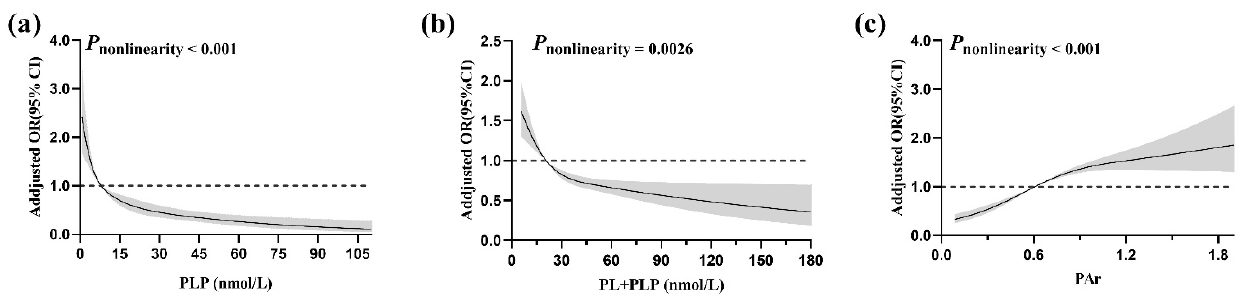
Figure 1. Relationships between serum PLP ( a ), PL plus PLP ( b ), PAr ( c ) levels and colorectal cancer risk by the restricted cubic spline model. The models were adjusted for age, sex, BMI, education level, income level, marital status, smoking status, occupational activity, MET-h/week, multivitamin supplement use, protein intake, total energy intake, vitamin B 2 intake, folate intake, vitamin B 12 intake, and methionine intake. The median of individual biomarker is the reference. The shaded areas represent 95% CI. PL, pyridoxal; PLP, pyridoxal 5 ′ -phosphate; PA, 4-pyridoxic acid; PAr, PA/(PL + PLP) ratio.